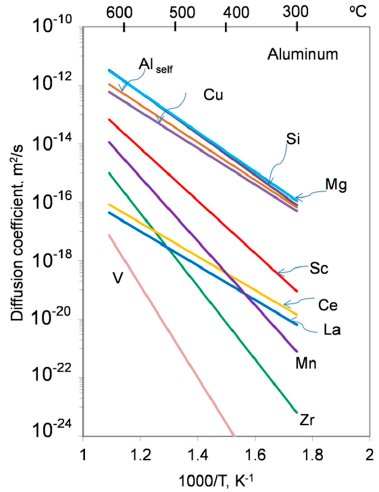
Figure 8. Semi-logarithmic plot of diffusivity in aluminum versus reciprocal temperature for alloying elements, representing transition metals, rare earth and non-transition metals, along with aluminum self-diffusion. Plot based on data selected from Tables A1–A3 in Appendix A.